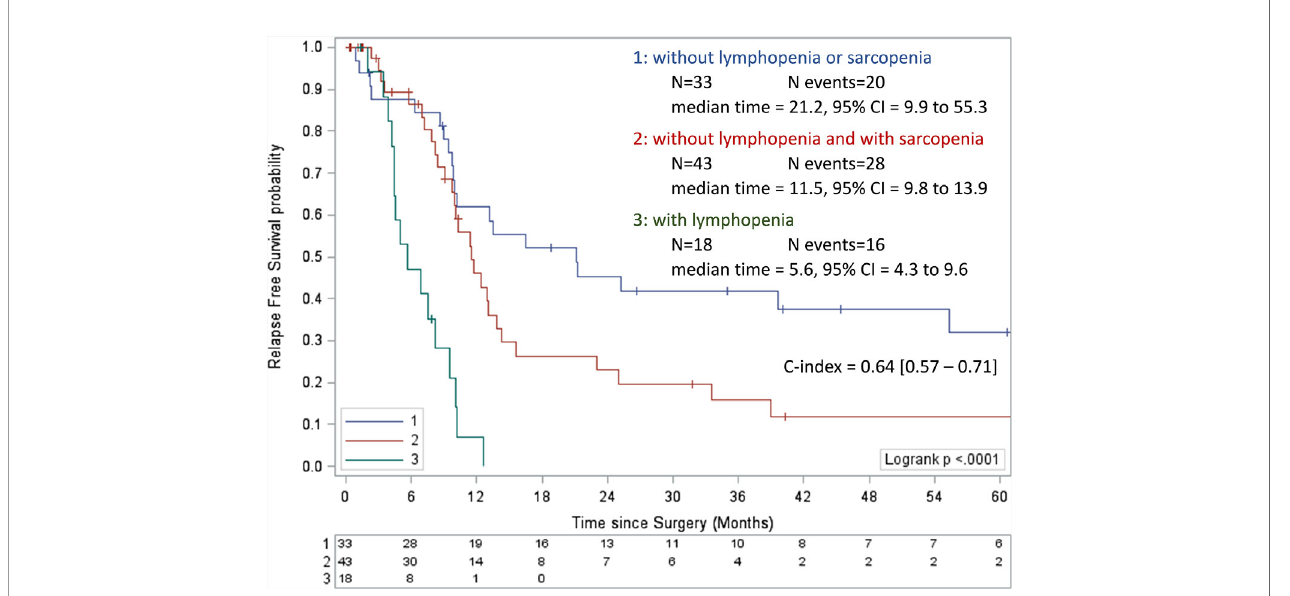
FIGURE 2 | Kaplan-Meier curves of relapse-free survival according to preoperative lymphopenia and sarcopenia. Values of the log-rank test P <0.05 were considered statistically signi fi cant, and all tests were two-sided. CI, con fi dence interval.